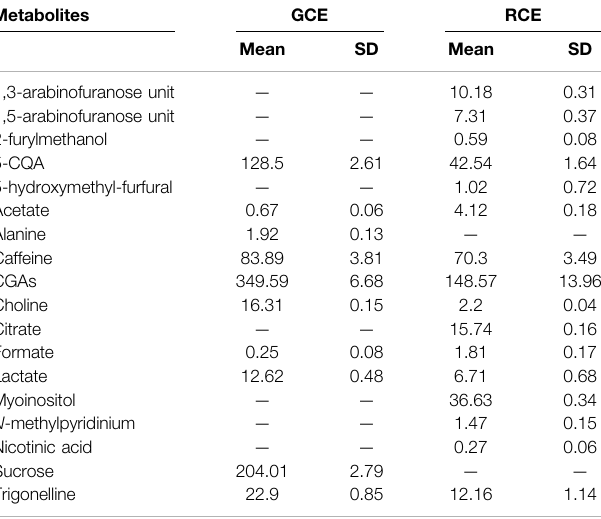
TABLE 1 | Metabolite quanti fi cation in GCE and RCE. Metabolites GCE RCE Mean SD